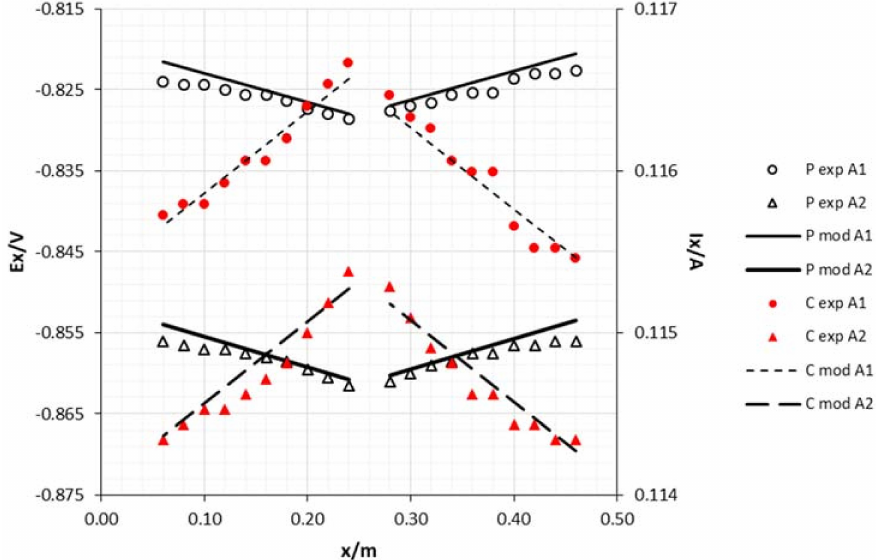
Figure 6. Experimental and model attenuation curves as a function of sacrificial anode area (cathode diameter 15 mm and middle draining point). Legend: P—potential; C—current; exp—experimental; mod—model; A1—anode area 0.0018 m 2 ; A2—anode area 0.0054 m 2